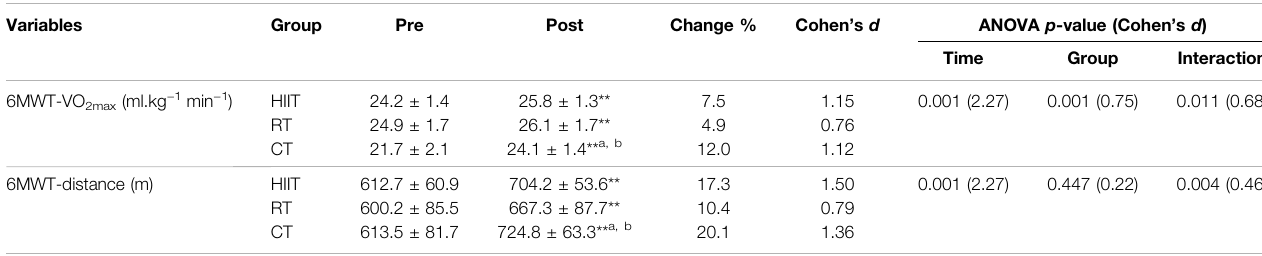
TABLE 7 | Effects of 9 weeks of training on the six-minute walking test (mean ±